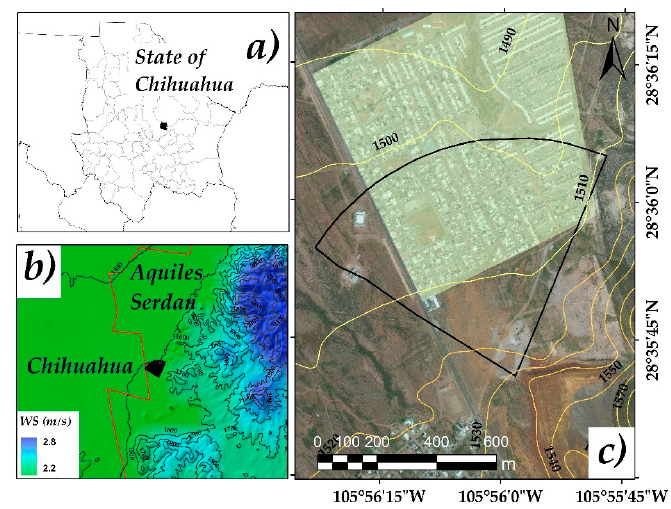
Figure 1. Study area location. ( a ) State of Chihuahua , ( b ) wind speed in the Municipality limits of Aquiles Serdán and Chihuahua, ( c ) research area in San Guillermo. Study area ( □ ), human settlements ( ■ ), WS = wind speed, contour lines (~), and municipality limits (-).